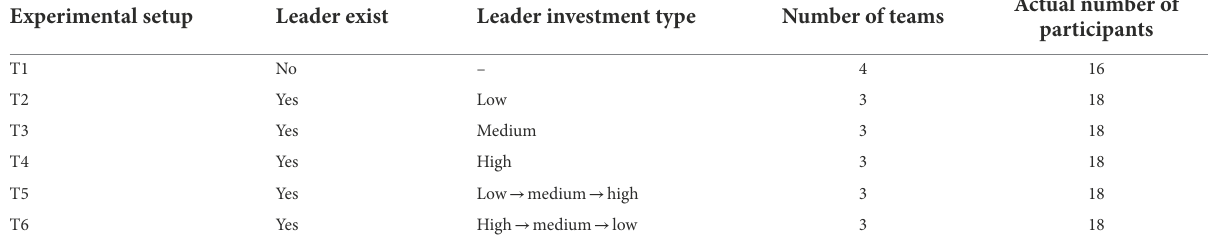
TABLE 1 Experiment setup and type. Experimental